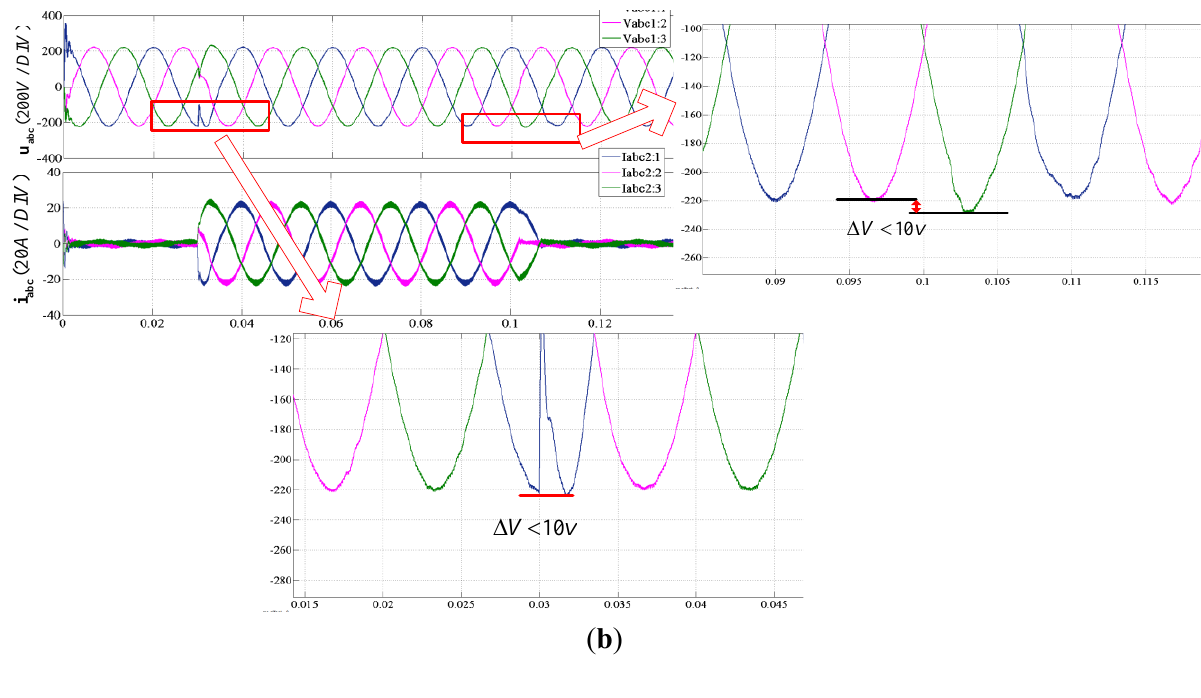
Figure 13. Simulation results of the propose control strategy under Scenario 1: ( a ) without LCO; ( b ) with LCO.